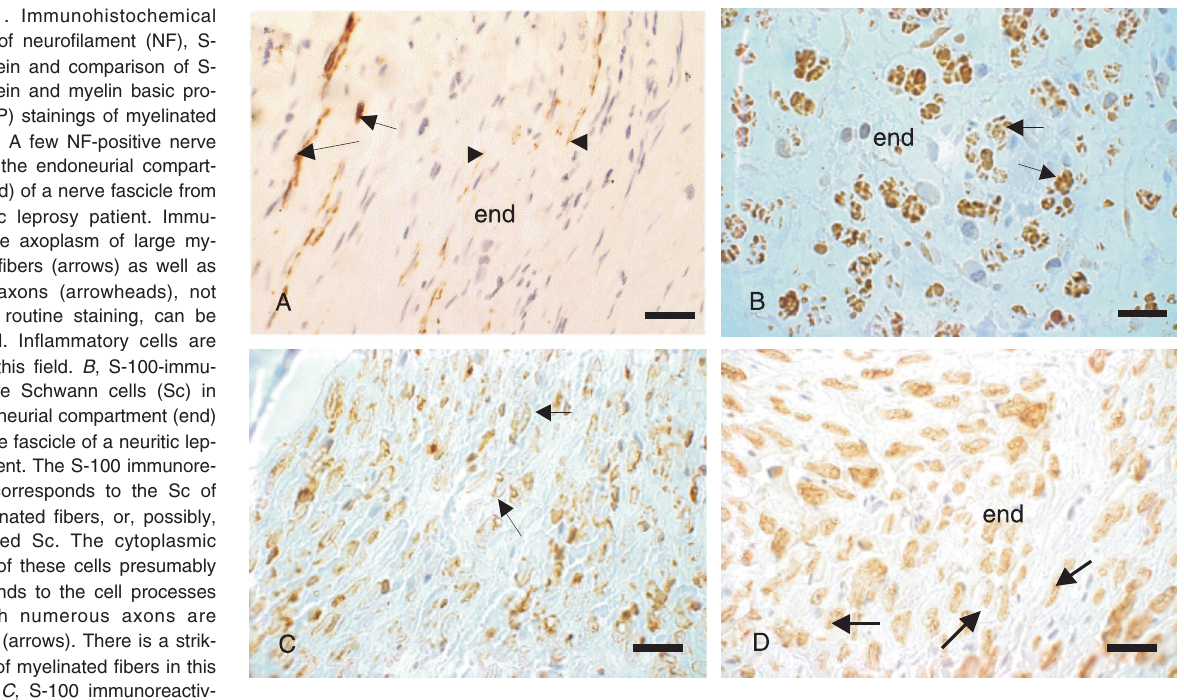
Figure 1. Immunohistochemical staining of neurofilament (NF), S- 100 protein and comparison of S- 100 protein and myelin basic pro- tein (MBP) stainings of myelinated